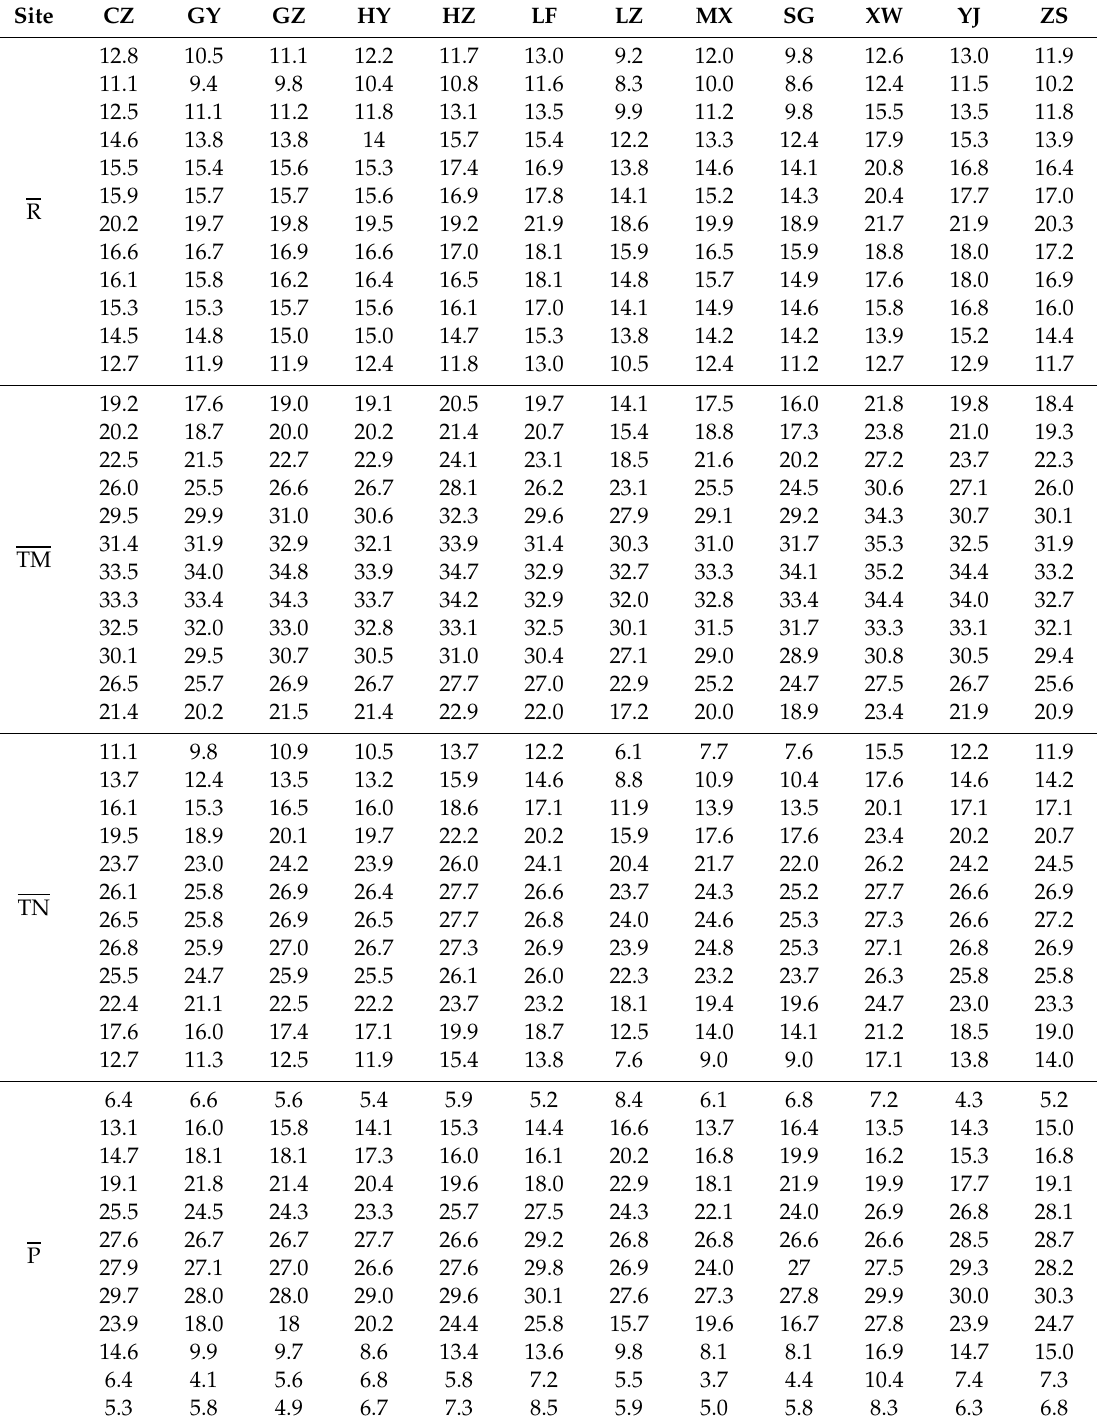
Table A6. Climate patterns under the 2.0 ◦ C warming